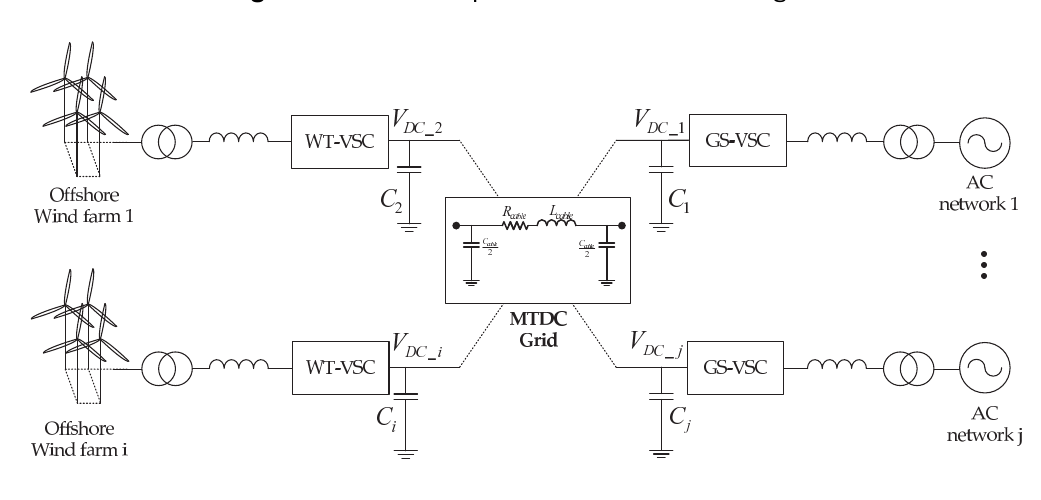
Figure 6. Generic representation of a MTDC